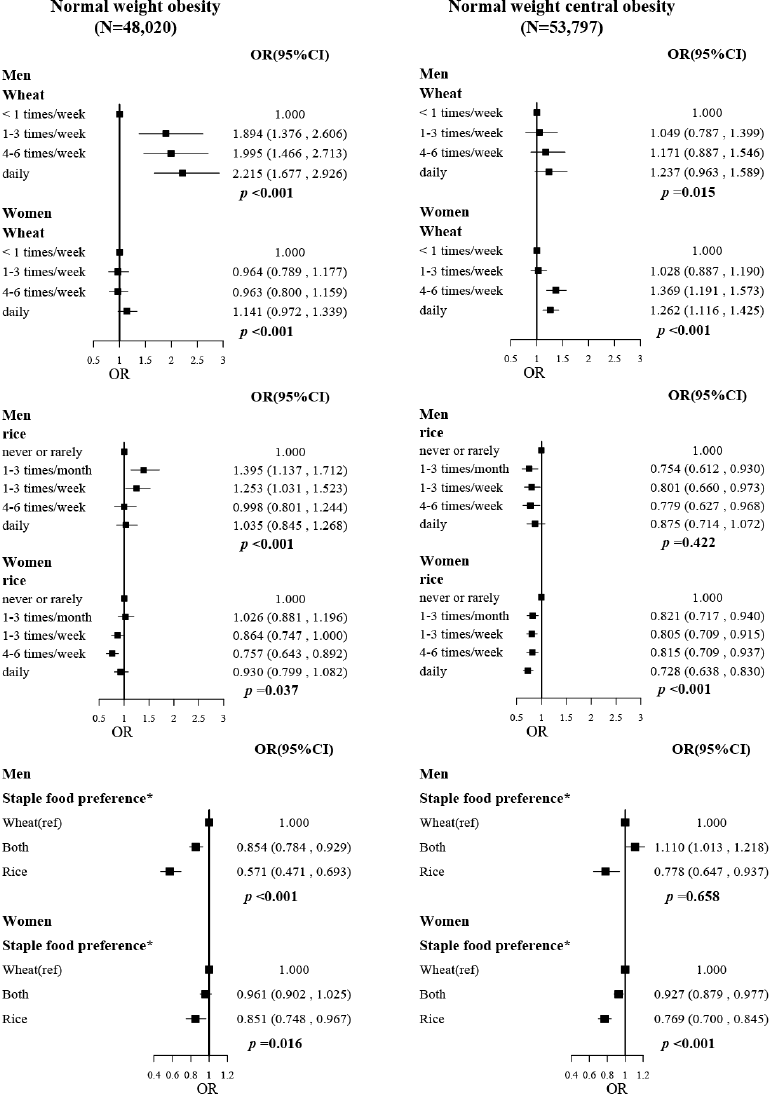
Figure 2. The associations of wheat intake, rice intake, and staple food preference with normal-weight obesity and normal-weight central obesity. The “N” on the top of the figure is the total number of participants included in the analysis. Models were fitted based on model 3, with adjustment of age, province, ethnicity, drinking status, smoking status, family income, education level, and physical activity (MET-hr/day). * Staple food preference: rice, consuming rice every day or 4–6 times per week and consuming wheat less than 4–6 times per week; wheat, consuming wheat every day or 4–6 times per week and consuming rice less than 4–6 times per week; both, the rest of the participants, which means they consumed rice and wheat with similar